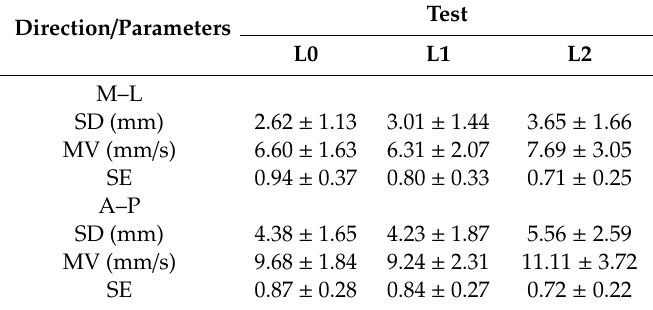
Table 1. Di ff erences in center-of-pressure (COP) parameters in individual experiments.